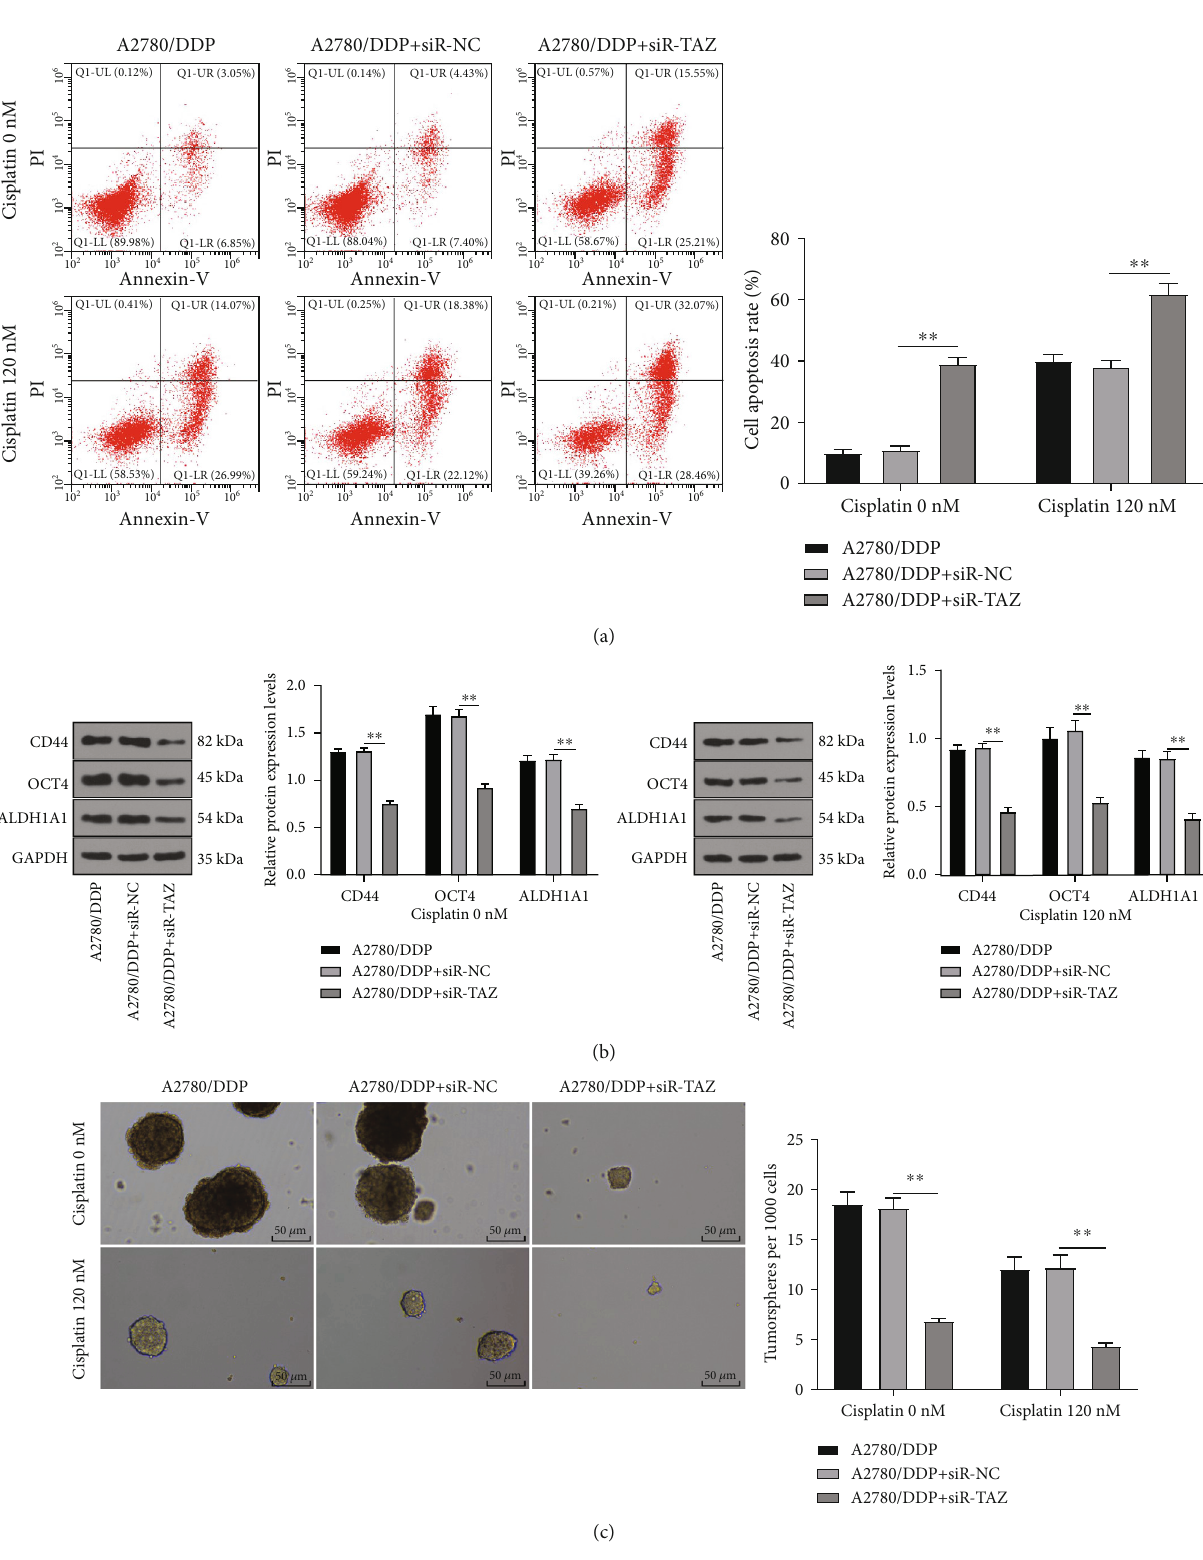
Figure 3: Knockdown of TAZ inhibited the drug-resistant EOC cell stemness. The drug-resistant EOC cells were transfected with siR-TAZ or treated with 120 nM cisplatin for 48 hours. (a) Apoptosis rate was measured by fl ow cytometry. (b) The expression of biomarkers for CSCs was detected by WB. (c) Impairment of tumorsphere formation was observed by spheroid formation assay. Cell experiment was repeated three times. Data were presented as mean ± SD , and one-way ANOVA was used for comparisons among groups. Tukey ’ s multiple comparisons test was employed for the post hoc test. ∗∗ P < 0 : 01